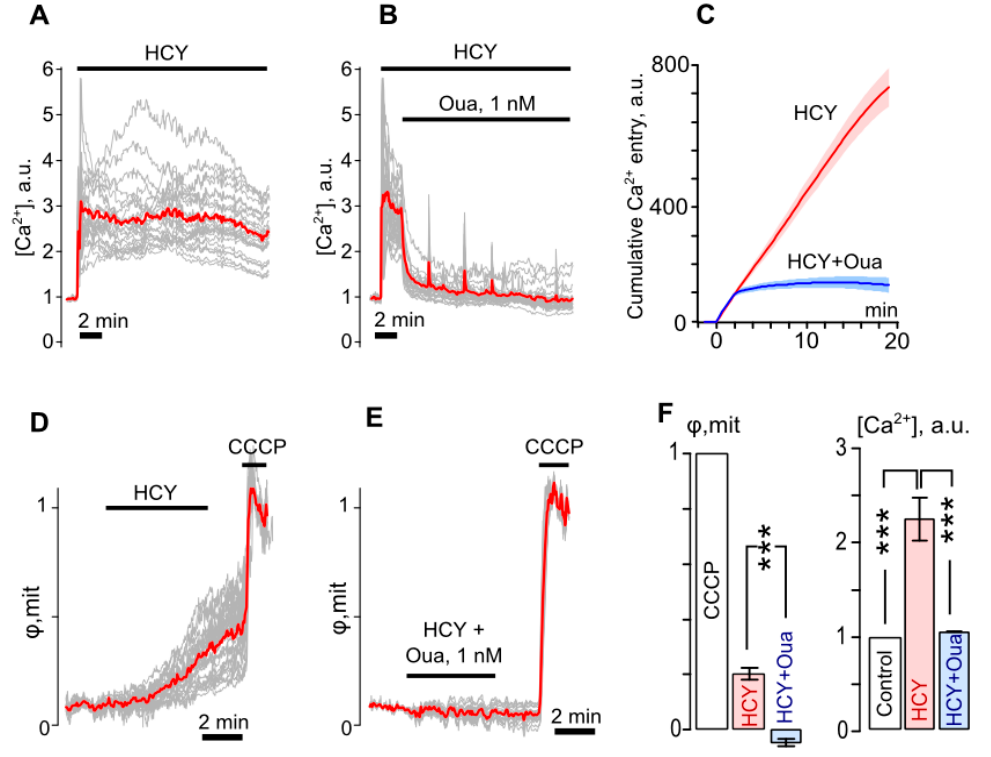
Figure 4. Ouabain prevents the intracellular Ca 2+ overload and the loss of mitochondrial inner membrane potential of cortical neurons caused by homocystein. ( A ) Fluorescent Ca 2+ responses of neurons loaded with Fluo-8 evoked by an application of 100 μ M homocystein + 30 μ M glycine (HCY) obtained from the same experiment and normalized to the fluorescence intensity recorded without HCY. Gray lines—responses of single neurons. Red line—an average response. ( B ) Ca 2+ responses when 1 nM Oua was added on top of HCY responses. ( C ) Average cumulative curves for Ca 2+ overload evoked HCY (red line) and with an addition of Oua (blue line), which represent an integral of fluorescent Ca 2+ responses shown in panels ( A , B ). Mean value ± SEM for each point is plotted ( n = 4). ( D ) Fluorescent responses of neurons loaded with rhodamine-123 evoked by an application of 100 μ M homocystein + 30 μ M glycine (HCY), which reflect the loss of mitochondrial inner membrane voltage ( φ mit ) obtained from the same experiment and normalized to the fluorescence intensity recorded in the presence of 4 μ M CCCP. Gray lines—responses of single neurons. Red line—an average response. ( E ) Changes of φ mit when 1 nM Oua was added to HCY. ( F ) Histograms compare average values of φ mit obtained with HCY and combined application of HCY and Oua in relation to full loss of φ mit in the presence of CCCP (on the left, n = 5) and Ca 2+ response amplitudes ([Ca 2+ ]) obtained under control and with Glu and combined application of HCY and Oua (on the right, n = 5). ***—Data are significantly different ( p = 0.0004, ANOVA with Tukey’s post- hoc test).